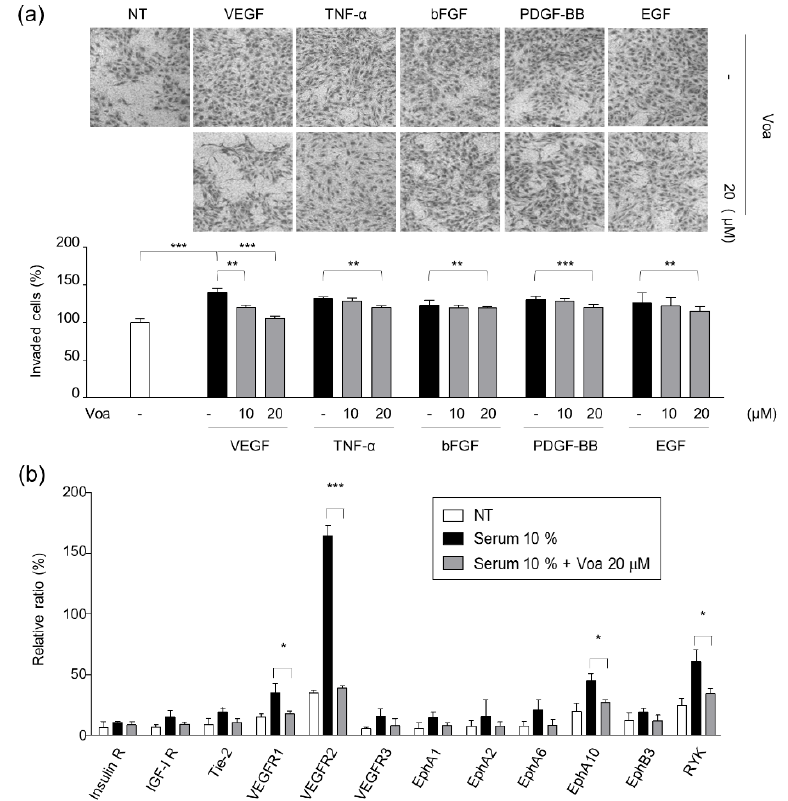
Figure 2. Voacangine specifically inhibited vascular endothelial growth factor (VEGF)-induced angiogenesis. ( a ) E ff ect of voacangine on chemoinvasion induced by various growth factors (VEGF, TNF- α , bFGF, PDGF-BB, and EGF). *** p < 0.001, ** p < 0.01 versus control of representative growth factors. -: Non-treated ( b ) Quantitation of the results from human p-RTKs array assay in HUVECs. The images are the representative of three independent experiments. Each value represents the mean ± S.D. from three independent experiments. *** p < 0.001, * p < 0.05 versus control. NT: non-treated control, Voa: